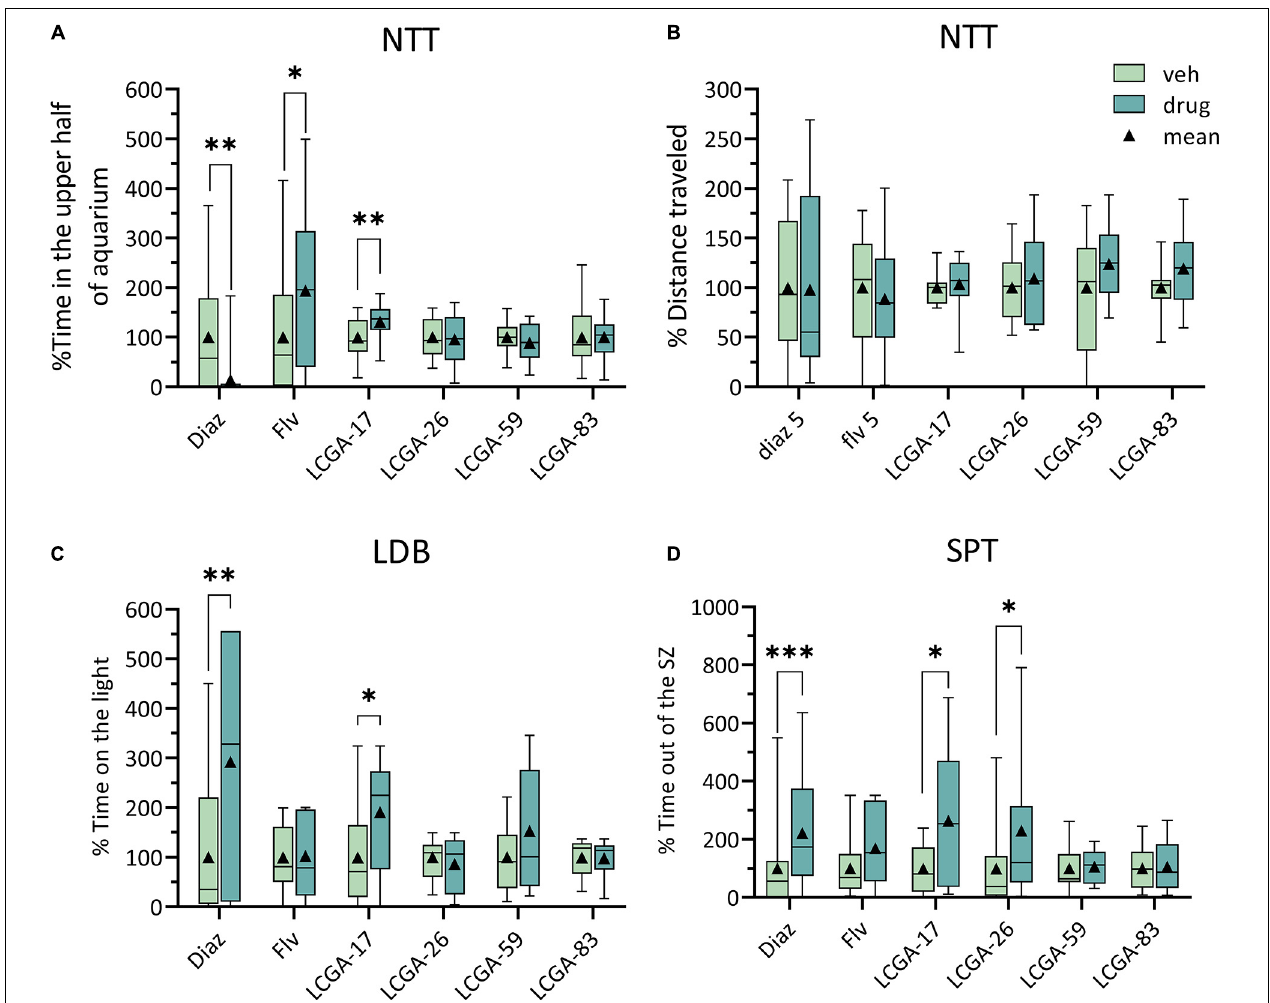
FIGURE 2 | Behavioral analyses of the anxiolytic-like properties of LCGA tetra-peptides in Danio rerio . (A,B) In the NTT, LCGA-17 (10 mg/kg) increased the time the fish spent in the upper half of the tank, similar to fluvoxamine (Flv, 5 mg/kg), indicating an anxiolytic-like response (A) . By contrast, diazepam (Diaz, 5 mg/kg) reduced the time spent in the upper half of the tank (A) . None of the treatments affected the distance traveled (B) . (C) In the LDB, LCGA-17 increased the time spent in the lit compartment, closely mimicking the anxiolytic-like effect of diazepam. (D) In the SPT, both LGCA-17 and LCGA-26 increased the time spent out of the shoaling zone, again mimicking an anxiolytic-like effect of diazepam. Neither fluvoxamine (5 mg/kg) nor LCGA-59 and LCGA-83 (10 mg/kg) affected the behavior in the LDB and SPT (B,C) . Data are presented as % of vehicle control. ∗ p < 0.05, ∗∗ p < 0.01, ∗∗∗ p ≤ 0.001, n = 18–30, Mann–Whitney, with corrections for multiple comparisons using the FDR method, at a q threshold of